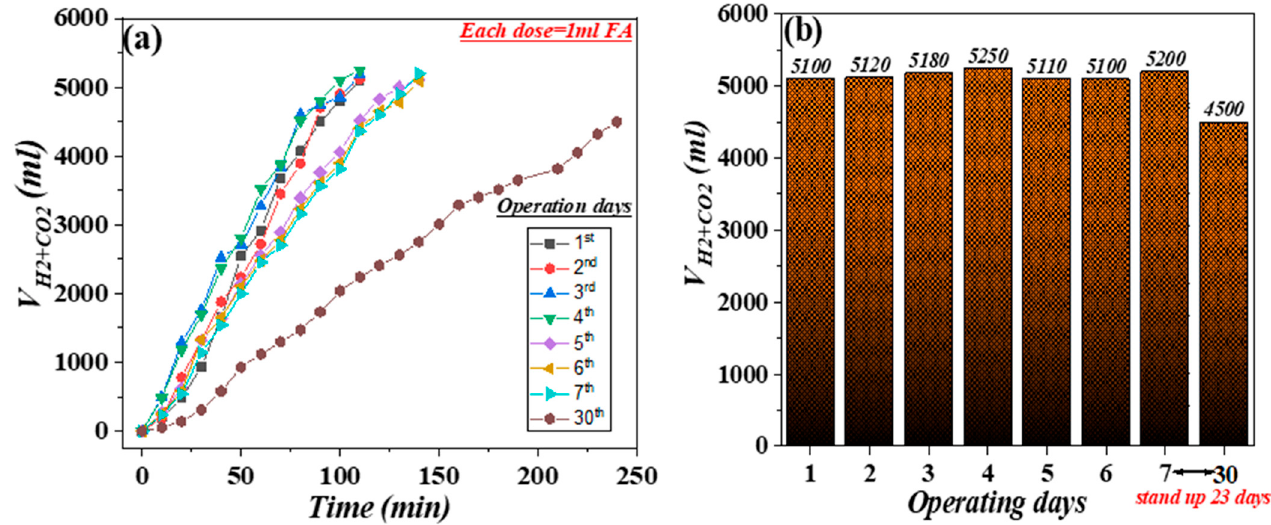
Figure 1. ( a ) Kinetics of gas production and ( b ) total gas volume produced every operation’s day. Conditions : (Ru/PP3) (9 μ mol) in tri-glyme:water (v/v = 10 mL:1 mL) solution which contained FA and 10 mmol of KOH at 85 °C .